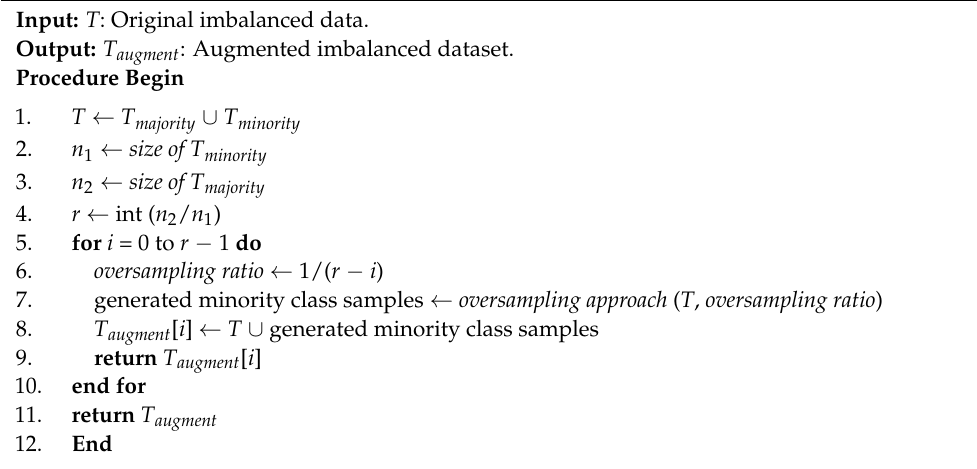
Algorithm 1 Oversampling-based imbalanced data augmentation